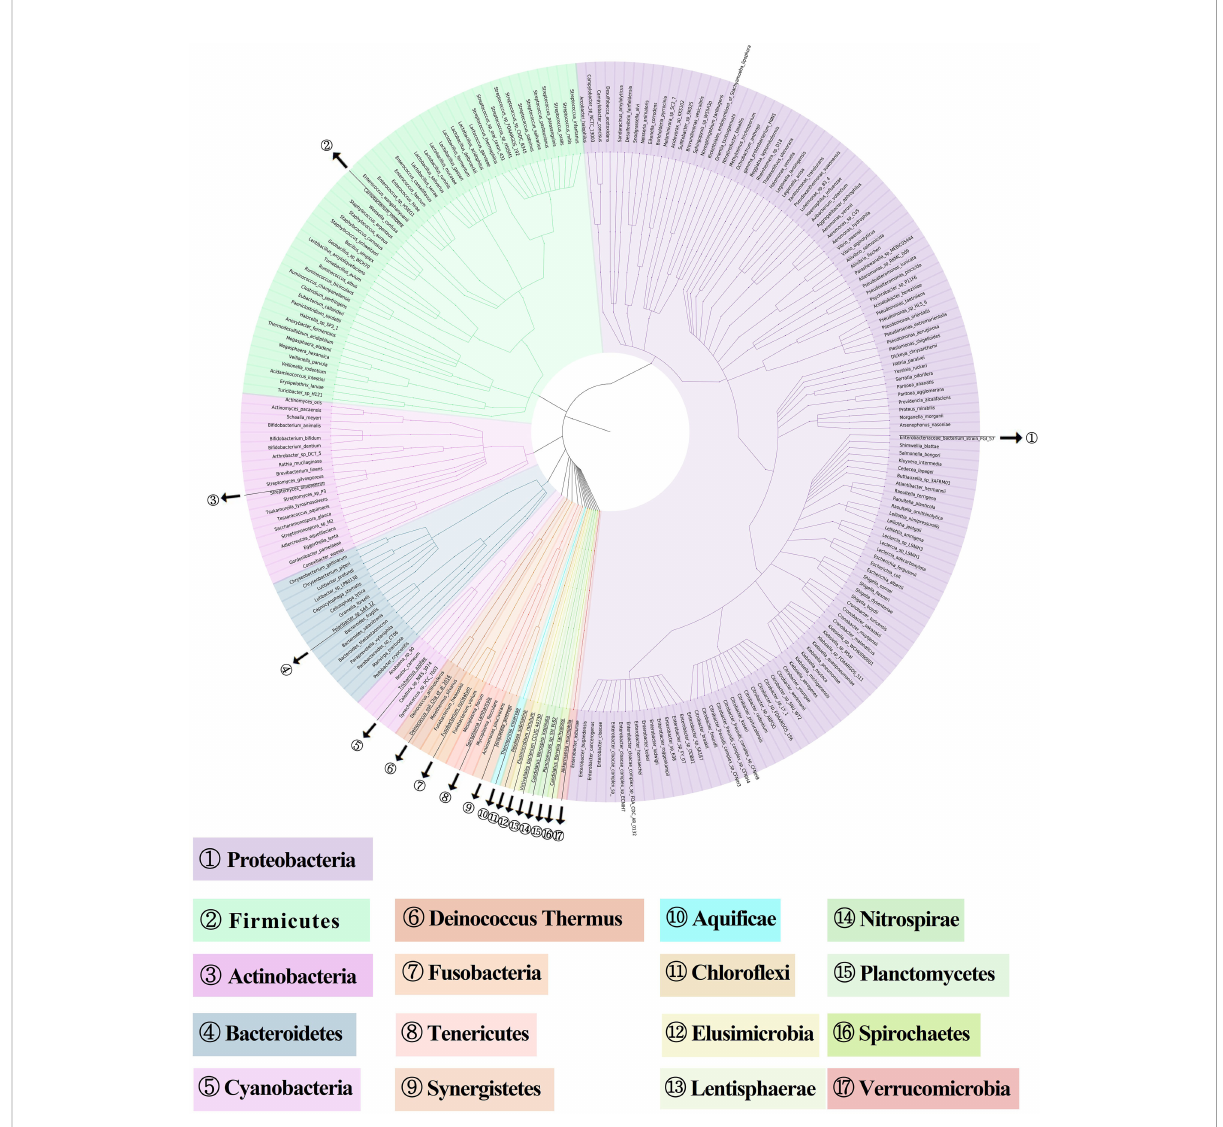
FIGURE 1 Metagenome-based diversity analysis of RAU gut microbiota. In total, 238 abundant species between RAU patients and healthy controls are shown in a phylogenetic tree according to the color code. The phylums of bacterias are given in the outer circles with circled numbers which including 17